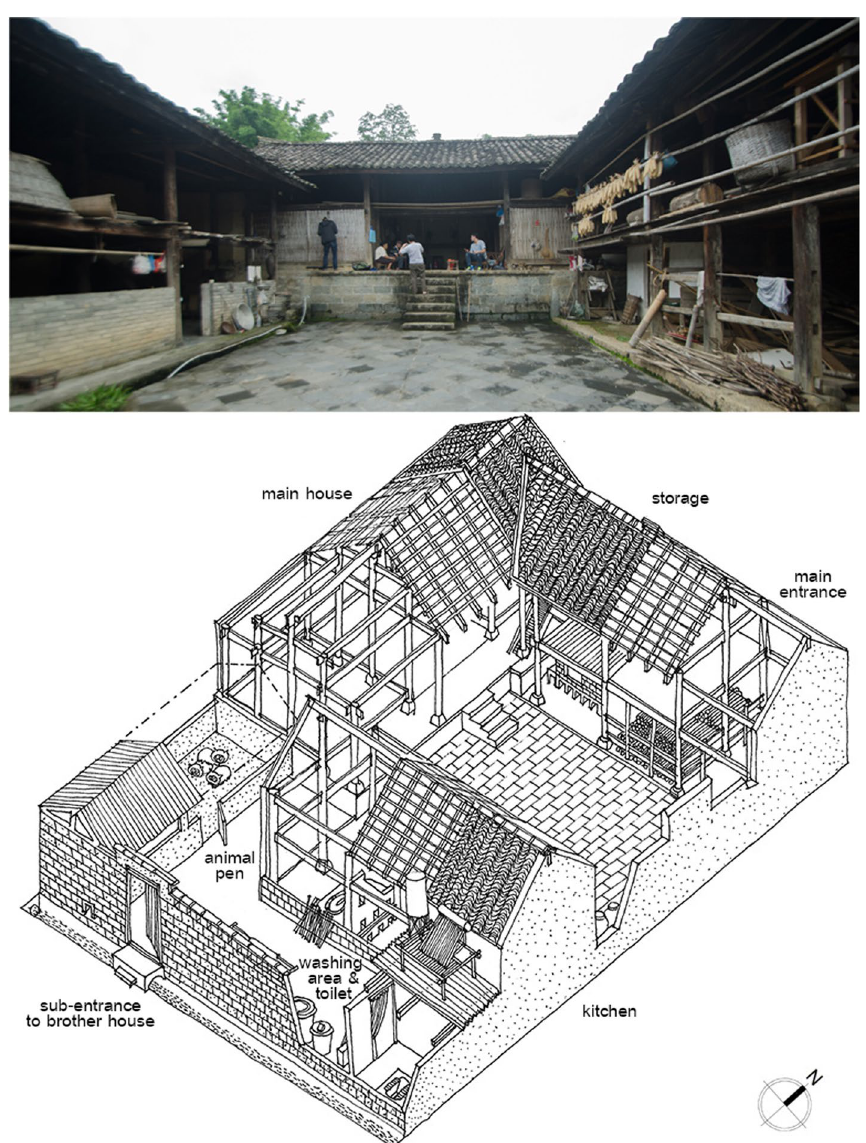
Fig. 5 Photograph and isometric house sketch showing spatial allocation, materials and structures (Source: the